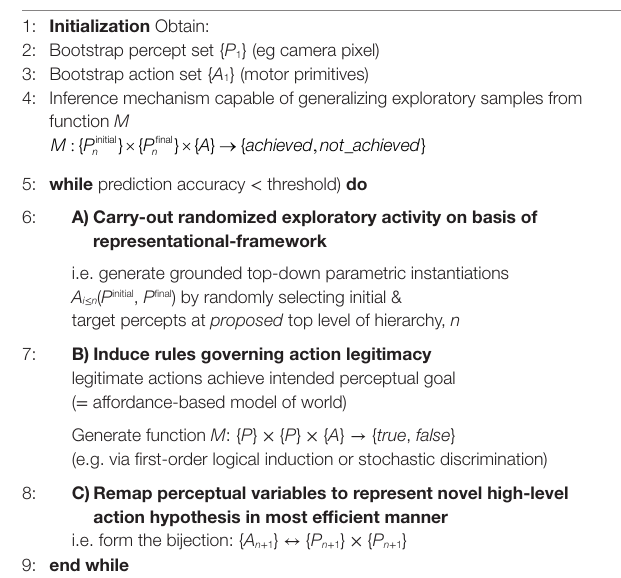
ALGOritHm 1 | Ab Initio Induction of Perception-Action Hierarchy in Artificial